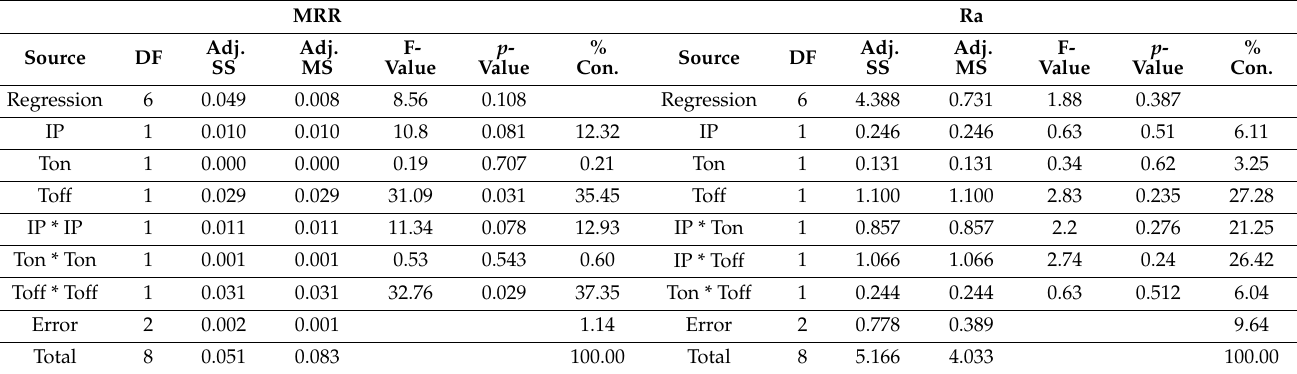
Table 5. Analysis of variance for the untreated electrode.